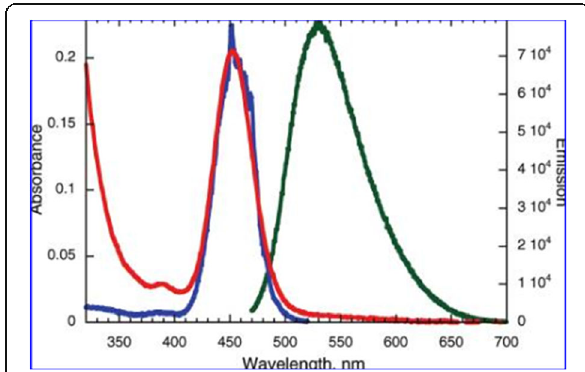
Fig. 16 Absorption (red), emission (green), and excitation (blue) spectra of Ag particles after 4 min of irradiation in THF under the conditions of Fig. 15 and resuspension in toluene [92]